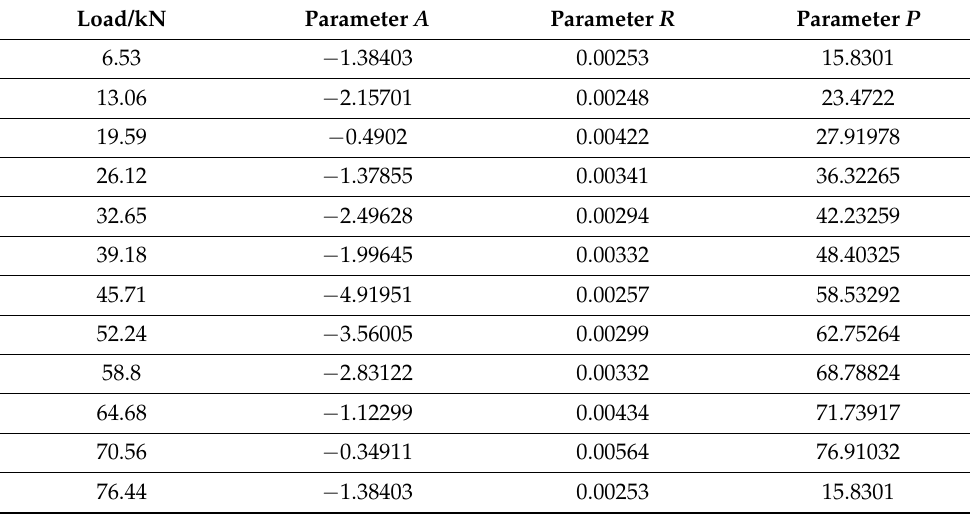
Table 2. Fitting parameters of bolt axial force under different load